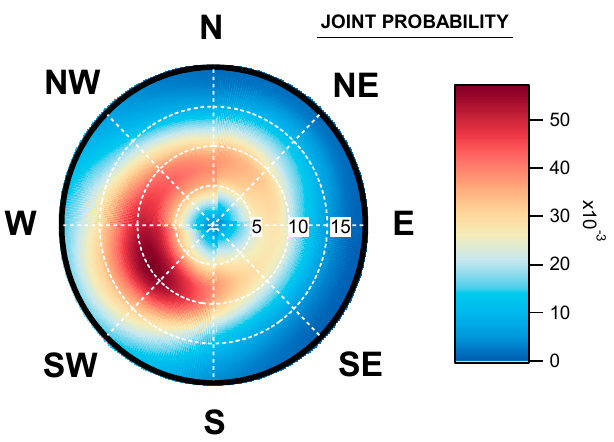
Figure A3. Prevailing wind directions affecting the Saclay observatory during the observation period from 10 January 2018 to 31 May 2020.